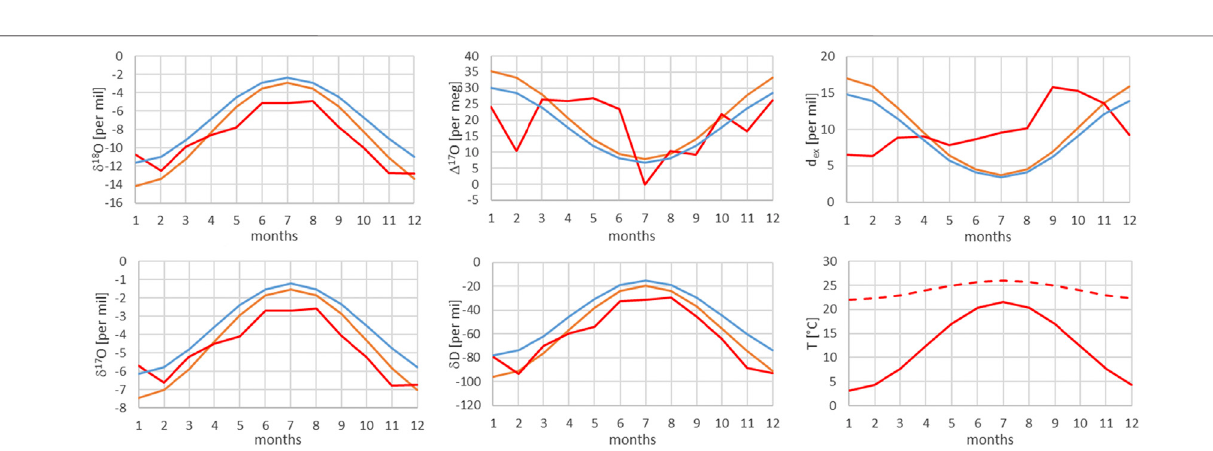
Frontiers in Earth Science |